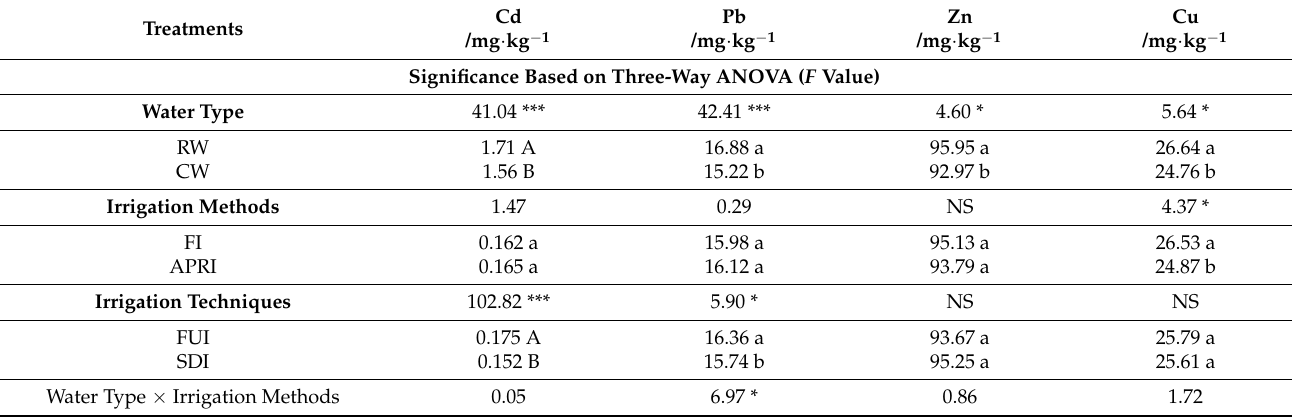
Table 4. Heavy metal properties in the surface soil under different irrigation